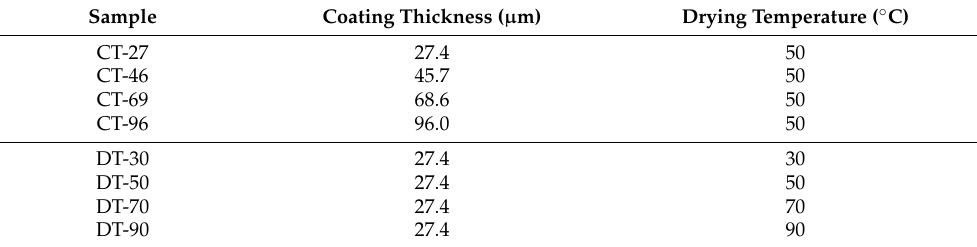
Table 2. Coating-drying conditions of the optimally formulated emulsion. (CT stands for the coating thickness; DT stands for the drying